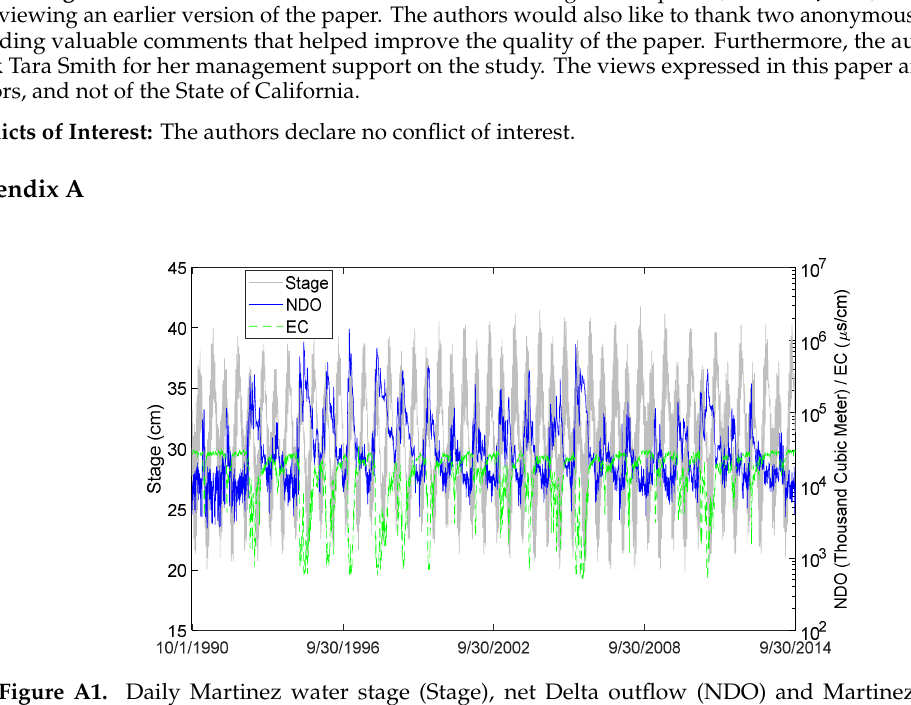
Figure A1. Daily Martinez water stage (Stage), net Delta outflow (NDO) and Martinez salinity represented by electrical conductivity (EC) during the study period (water year 1991–2014).